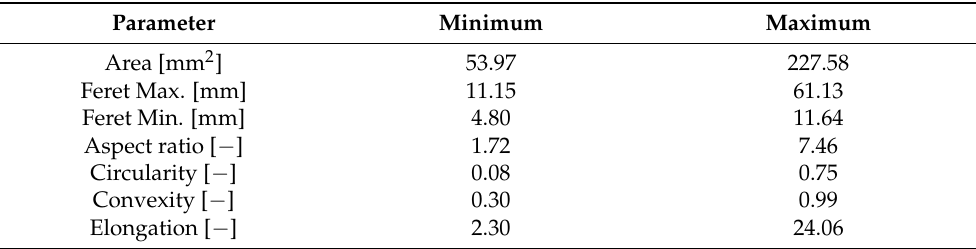
Table 5. Shape parameters of assessed defect